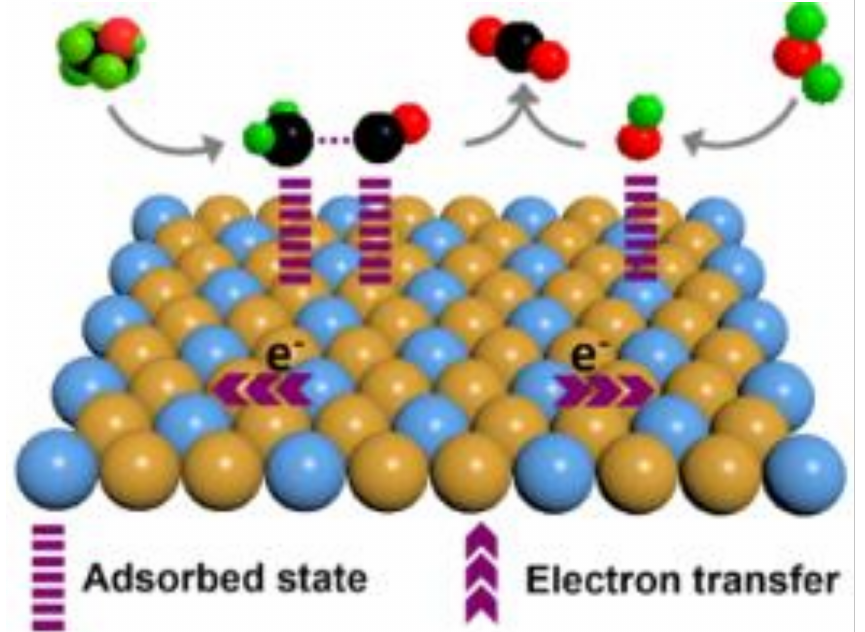
Figure 5. Bifunctional mechanism of ethanol oxidation reaction (EOR) on the PtSn (Pt—brown, Sn—blue) catalyst surface, reprinted with permission of American Chemical Society